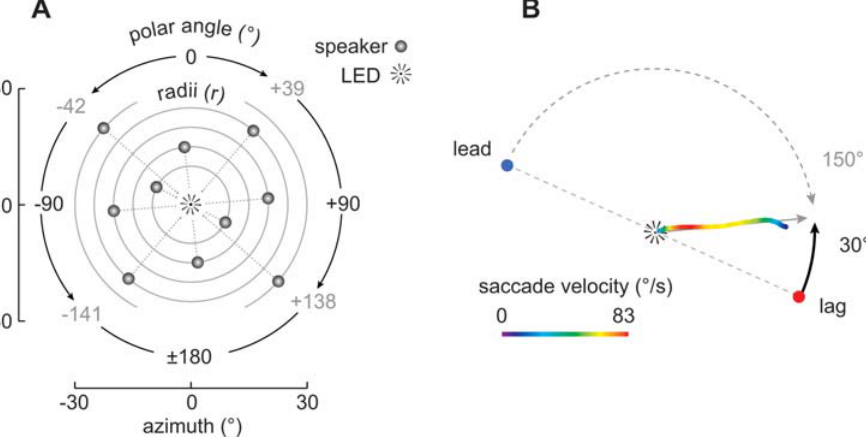
Figure 5. Behavioral paradigm. ( A ) Placement of 10 loudspeakers and a central fixation LED, in polar coordinates. In trials with a lead/lag pair, one of the pair of speakers was assigned a radius of 10 u , 15 u , 20 u , 25 u , or 30 u and a random polar angle. The second member of the pair had an identical radius, but was 180 u opposite the first speaker. Corresponding Cartesian coordinates (azimuth and elevation) are also shown. The stimulus paradigms used in the behavioral trials were identical to those shown in Fig. 1 for physiology. ( B ) Example of a head saccade. The saccade shown here was made with an unusually large error (30 u ) relative to that of the closest source, in this case, the lagging source. Despite this error, the angle of the saccade was far greater when compared with that of the leading source (150 u ), thereby allowing us to determine whether the saccade was lead- or lag- directed. The color scale indicates saccade velocity.